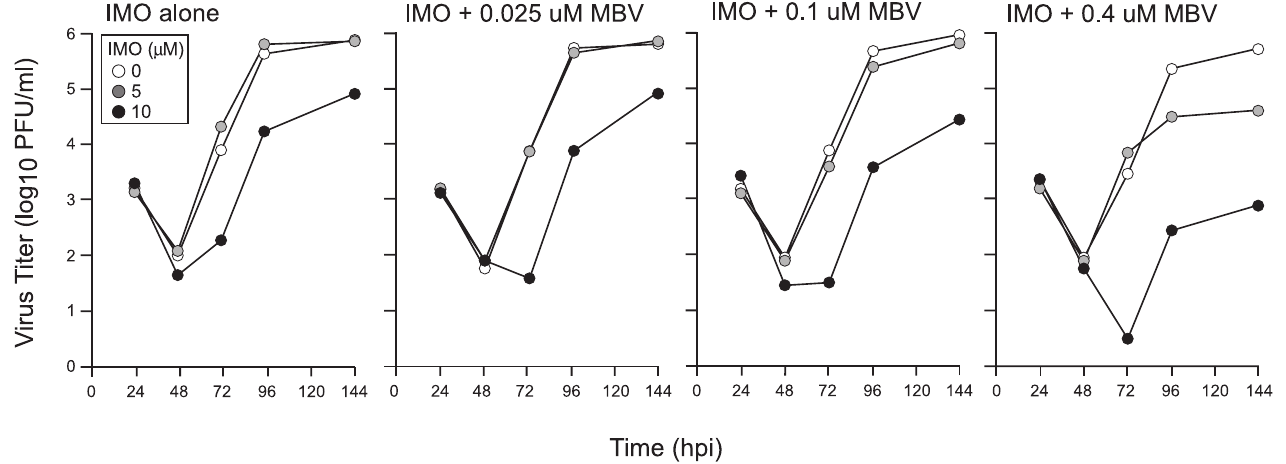
Figure 4. Checkerboard Analysis of Cellular Cdk Inhibitor IMO and VPK Inhibitor MBV on Viral Yields Mean infectivity (with standard deviation of four replicates indicated by error bars) determined by plaque assay on culture supernatants of HFs at 24, 48, 72, 96, and 144 h postinfection with AD169 var ATCC in the presence of 0, 5, or 10 l M IMO (left) or in combination with different concentrations of MBV (0.025, 0.1, and 0.4 l M) from one experiment.